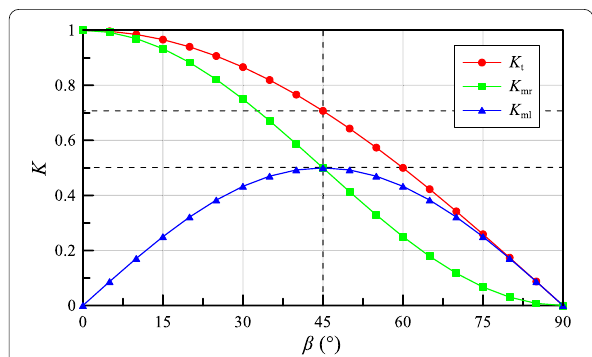
Figure 13 Influence of β on K t , K mr and K